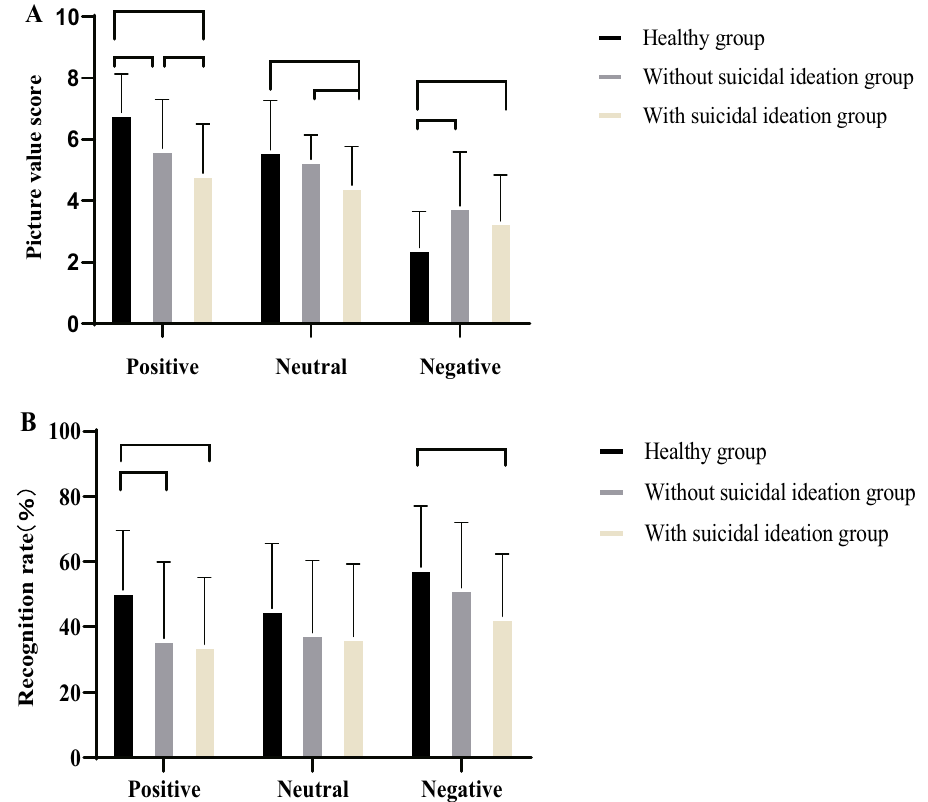
Figure 2. The valence scores and recogniton rates of positive, neutral, and negative emotion pictures were compared among groups. ( A ) Emotional picture valence score. ( B ) The accuracy of the picture recognition after 3 days.